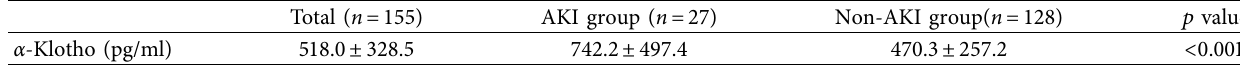
Table 2: Serum α -Klotho protein levels in AMI patients.